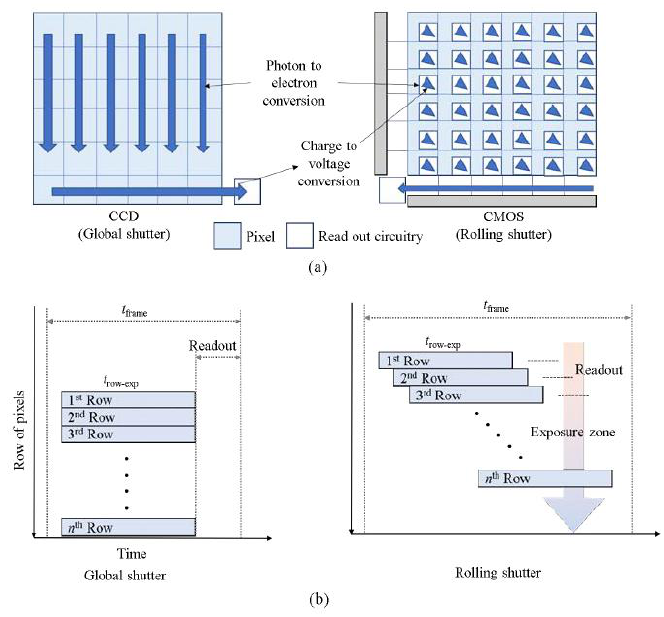
Figure 37. ( a ) CCD and CMOS image sensor; and ( b ) global and rolling shutter mechanisms.